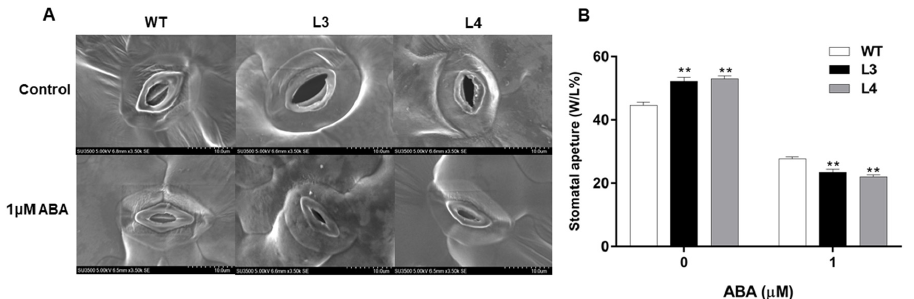
Figure 8. The stomatal aperture of WT and EjWRKY17 transgenic lines under ABA treatment ( A , B ). Error bars represent ± SD ( n = 3). Asterisks denote significant differences (as compared with the control group): ** p < 0.01.